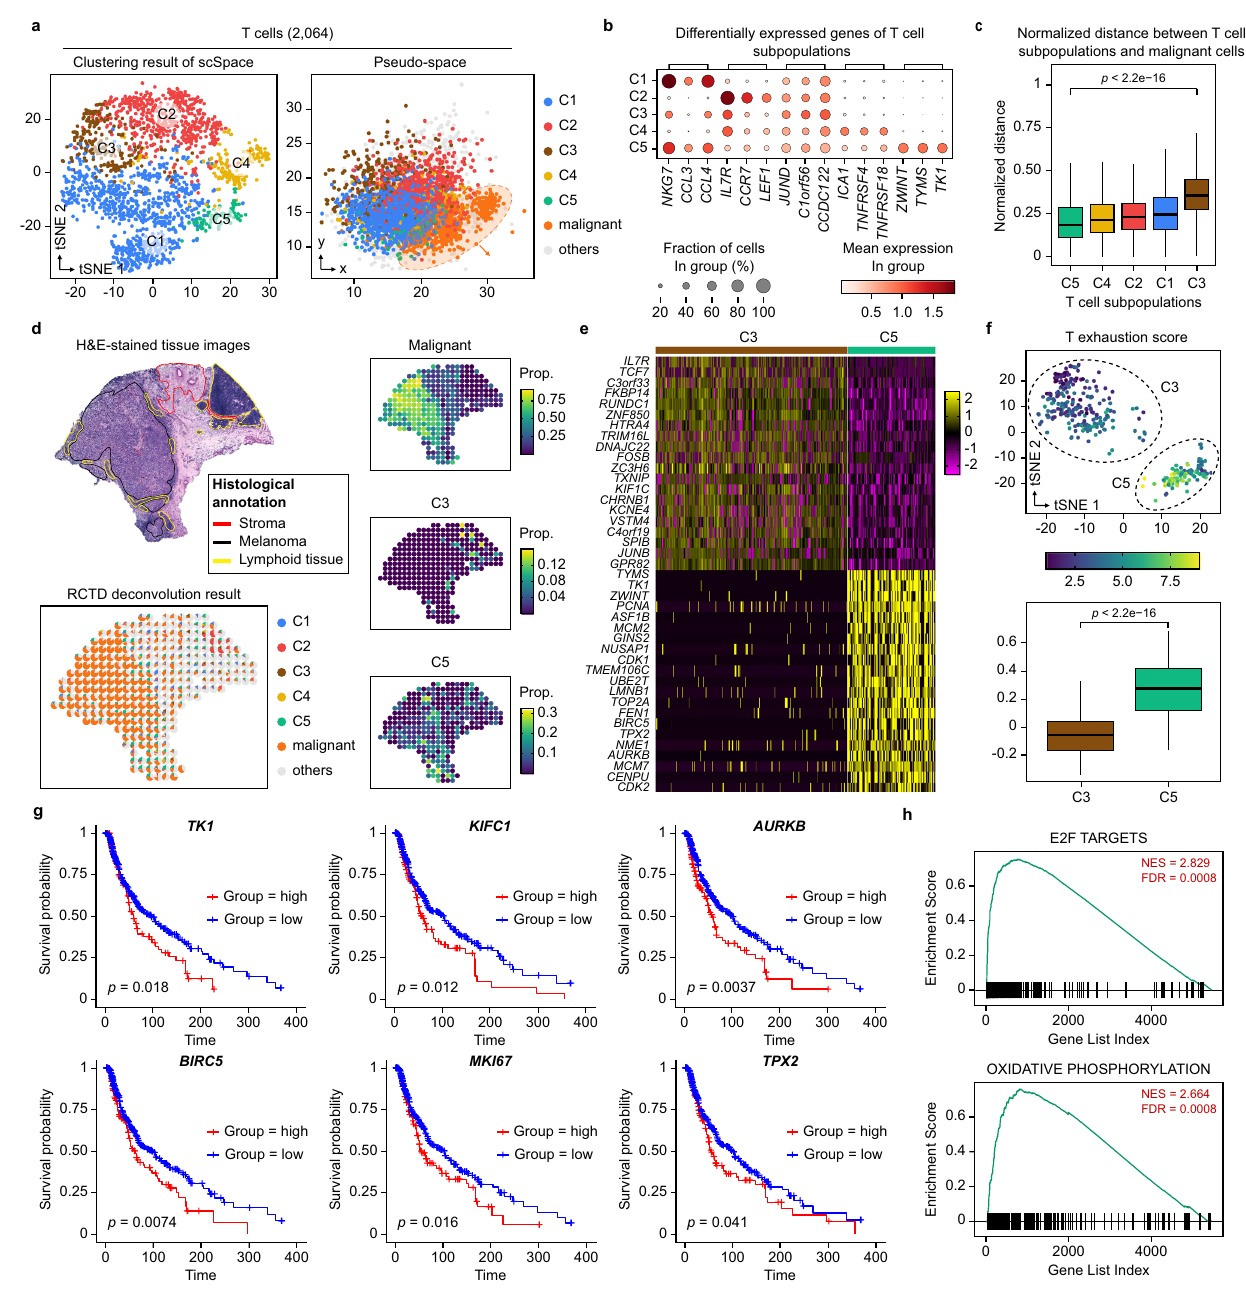
Fig.5|SpatialreconstructionofTcellpseudo-spacerevealedTcellexhaustion inmelanoma.a t-SNEvisualization(left)and thepseudo-space(right)of fi veTcell subpopulations identi fi ed by scSpace. All other cell types except T cells and malignantonesarelabeledas “ others ” . b Differentiallyexpressedgenesof fi veTcell subpopulations. c Normalized pairwise distance between different T cell sub- populations to malignant cells. Data are presented as boxplots (minima, 25th per- centile, median, 75th percentile, and maxima). The number of data points for the normalized pairwise distances to malignant cells are 144,555, 251,400, 731,574, 1,148,898, and 318,021, respectively. P -value is calculated with the two-sided Wil- coxon rank-sum test (the exact P -value is 0). d The spatial distribution of C3 and C5 subpopulations inthe spatialtranscriptomicsreferencecalculated by RCTD. All